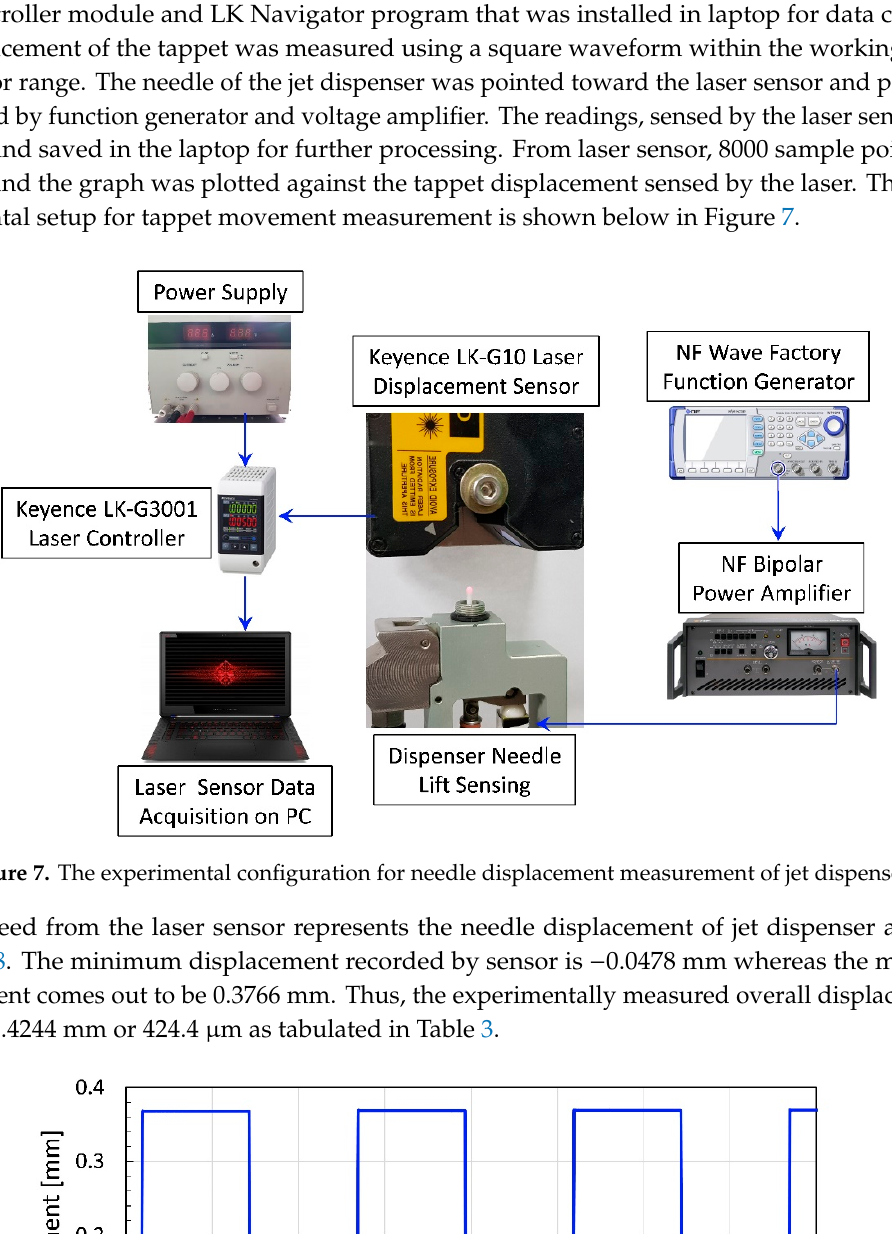
Table 3. Laser displacement-sensor experiment results.